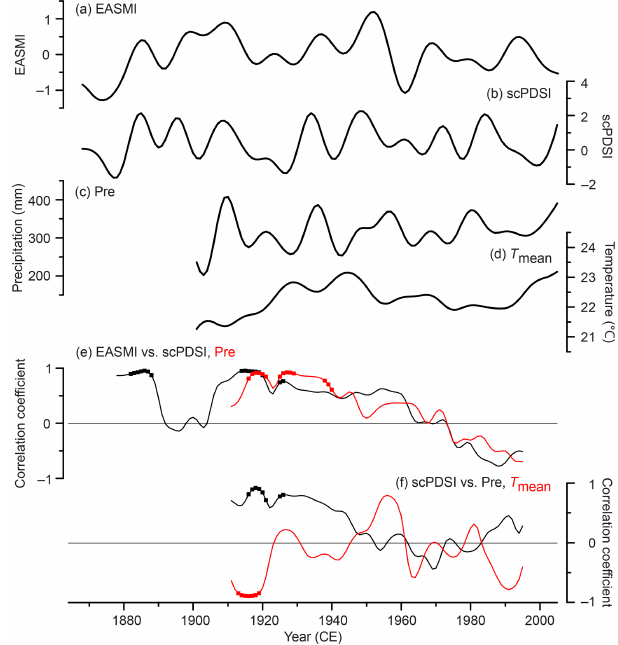
Figure 10. (a–b) The leading empirical orthogonal function (EOF) modes of decadal filtered May–July GPCC precipitation anomalies for the periods 1901–1978 (a) and 1979–2005 (b) . The color bar indicates the EOF values. (c–d) Spatial correlations between the decadal filtered May–July EASMI defined by Zhao et al. (2015) and precipitation (Pre) for the periods 1901–1978 (c) and 1979– 2005 (d) . The color bar indicates the correlation coefficient. Dots in- dicate correlation significant at p < 0 . 1. Decadal-scale and longer- term fluctuations of precipitation were derived using the adap- tive 10-point Butterworth low-pass filter with 0.1 cutoff frequency (Mann, 2008). The tree symbol denotes the study